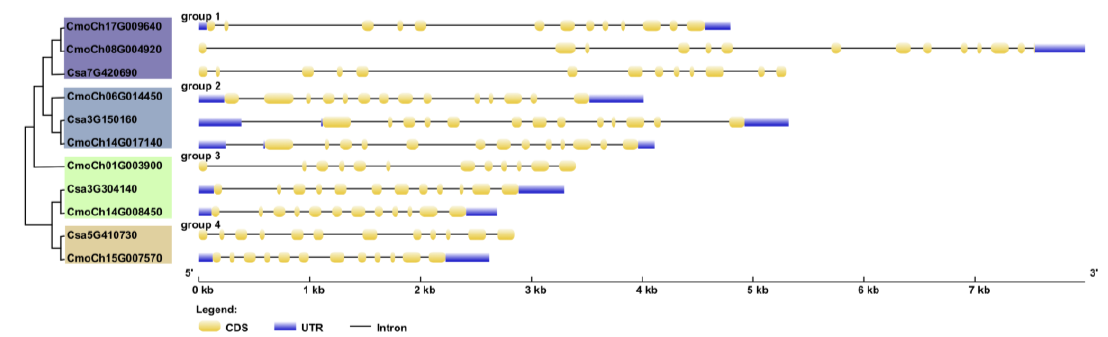
Figure 2. Structural analysis of CmoGS and CsaGS members. GS s in different subfamilies are indicated by different colors. The lower number axis shows the number of deoxynucleotides.